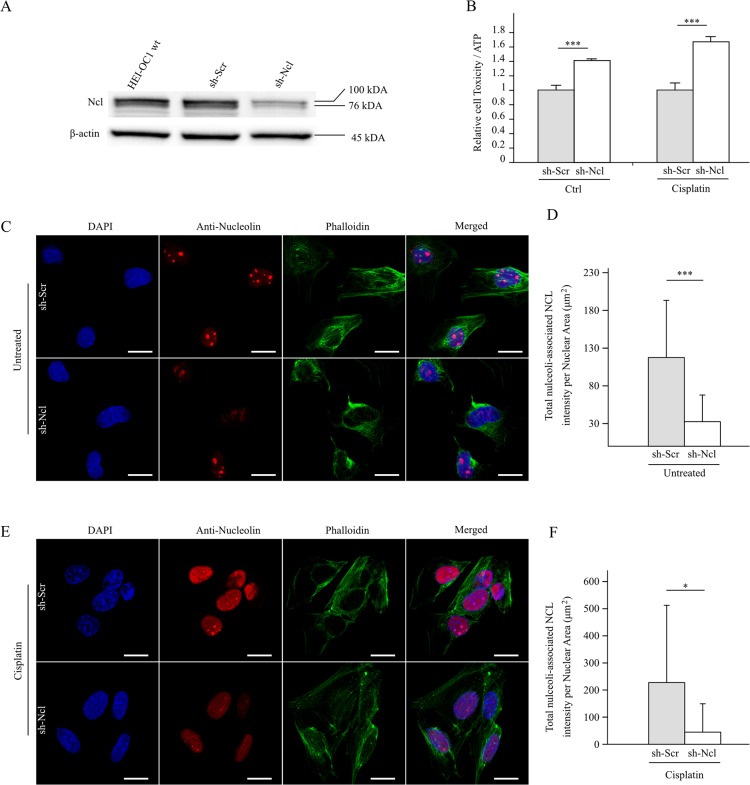
Down-regulation of nucleolin affects viability and nuclear redistribution in HEI-OC1 cells.(A) Western blots of two independent experimental replicates show HEI-OC1 wild type cells and transfected HEI-OC1 cells with either shRNA targeted against nucleolin (sh-Ncl) or with scramble shRNA control (sh-Scr). (B) Cytotoxicity of sh-Scr and sh-Ncl cells either untreateds or incubated 6 h with Cisplatin at 20 μM from duplicate experiments with n = 4. (C, D) Redistribution of nucleolin in shRNA-transformed HEI-OC1 cells. Transfected HEI-OC1 cells with shRNA targeted against nucleolin (sh-Ncl) or with scramble shRNA as control (sh-Scr) were untreated or (E, F) incubated with 20 μM Cisplatin for 6 h. Cells were stained with anti-nucleolin antibody decorated with secondary goat anti-rabbit IgG Texas-Red conjugate and counterstained with DAPIand phalloidin. Images were then merged to form color composite images. The images are representative of the results of each cell type and treatment. White scale bar represents 20 μm. The change in the total nucleolin intensity was normalized to nuclear area in untreated cells (D) or in cells incubated 6 h with cisplatin at 20μM (F). Statistical significance was assessed with Student's t-test (***p < 0.001, *p < 0.05). Experiments were performed in non-permissive conditions.